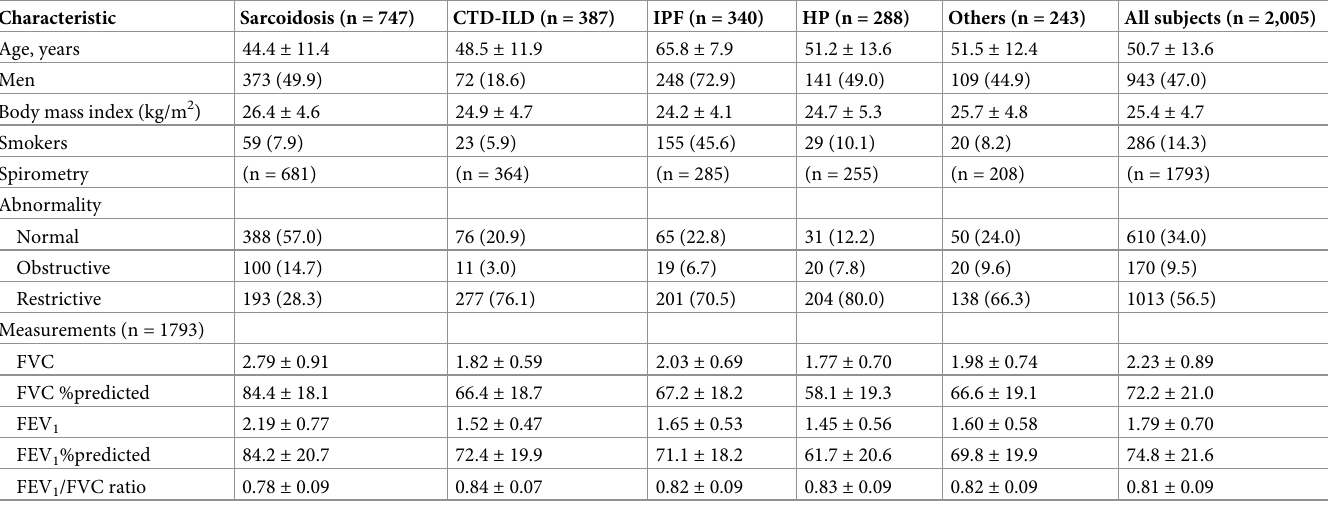
Table 1. Baseline characteristics of the subjects at study enrolment at the Chest Clinic (n = 2,005). Characteristic